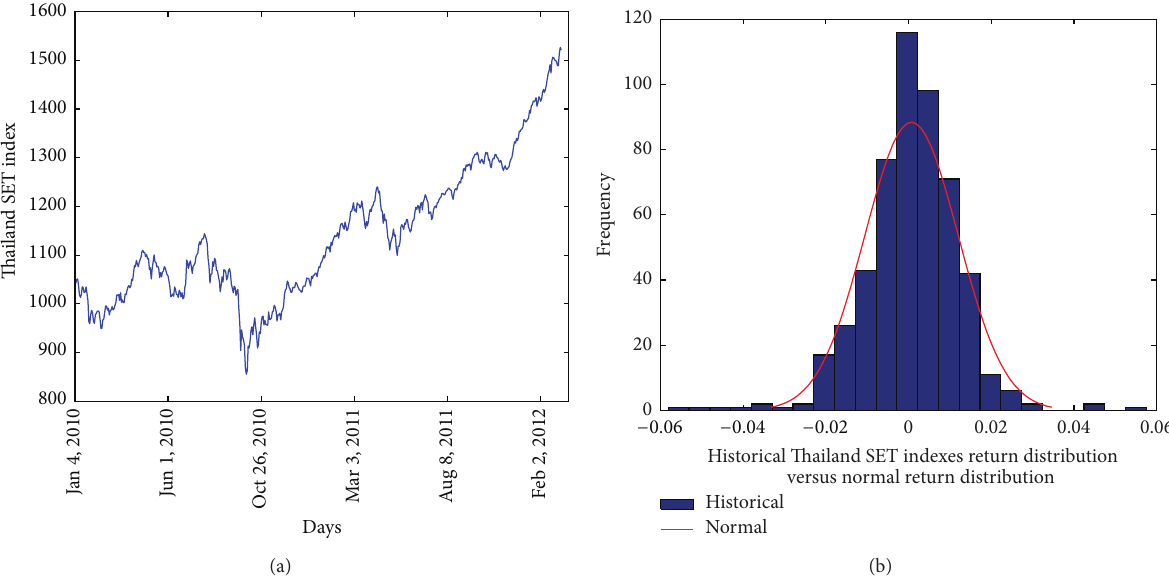
Figure 1: Historical value of SET index with sample period from January 2011 to February 2013 (a) and empirical distribution of daily log returns for the SET index and fitted normal distribution